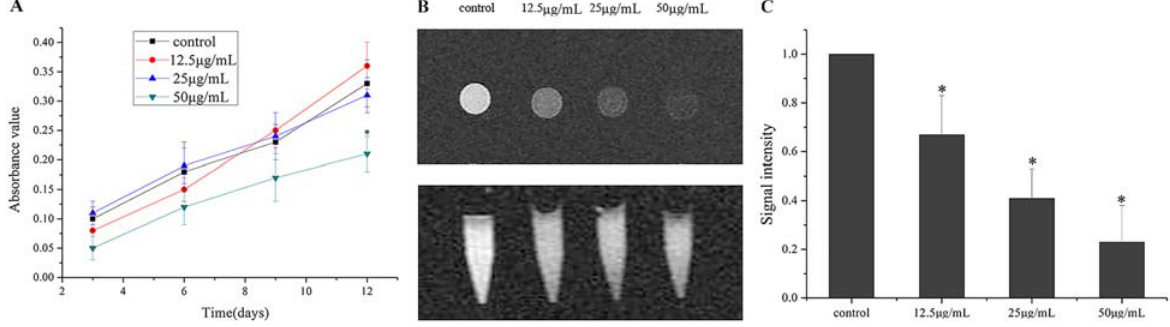
Figure 6. A , Cell proliferation was detected by CCK8 assay after endothelial progenitor cells (EPCs) were transfected with superparamagnetic iron oxide (SPIO) at different concentrations. B , Magnetic resonance plain scan imaging of EPCs transfected with SPIO at different concentrations. C , Gray value comparison of T2 weighted imaging of EPCs transfected with SPIO at different concentrations. Data are reported as means ± SD (ANOVA). *P o 0.05, compared to control